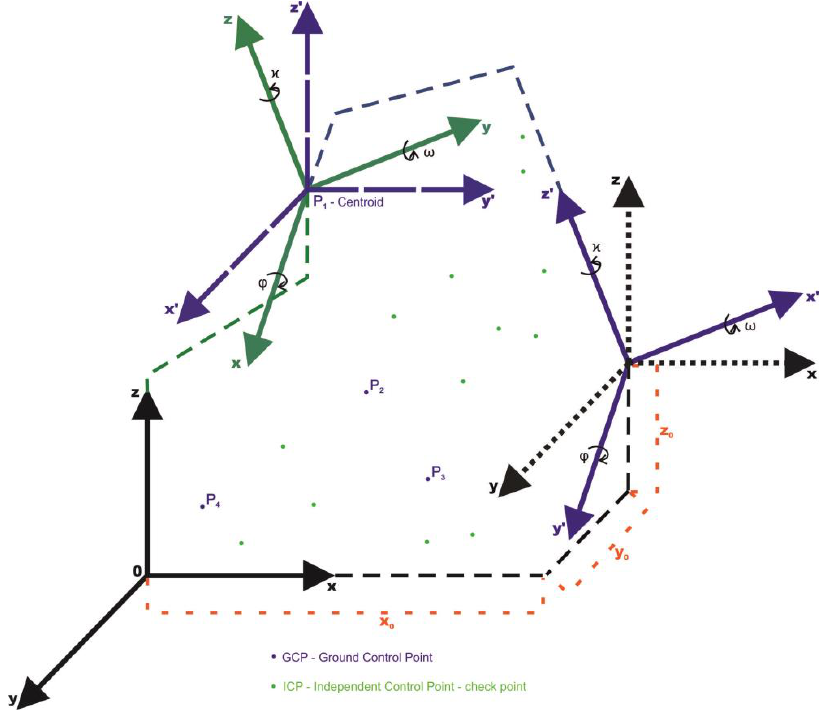
Figure 3. The transformation with the use of a centroid according to the relation (13) — development of TFS transformation [15].